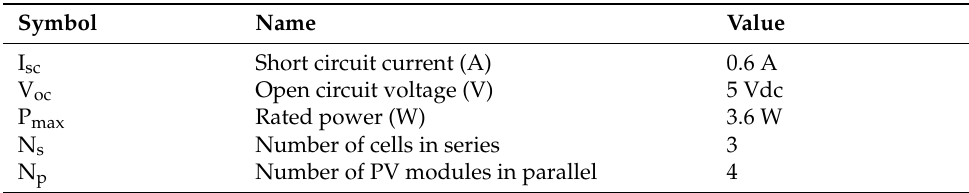
Table 3. Electrical characteristics data of reference PV